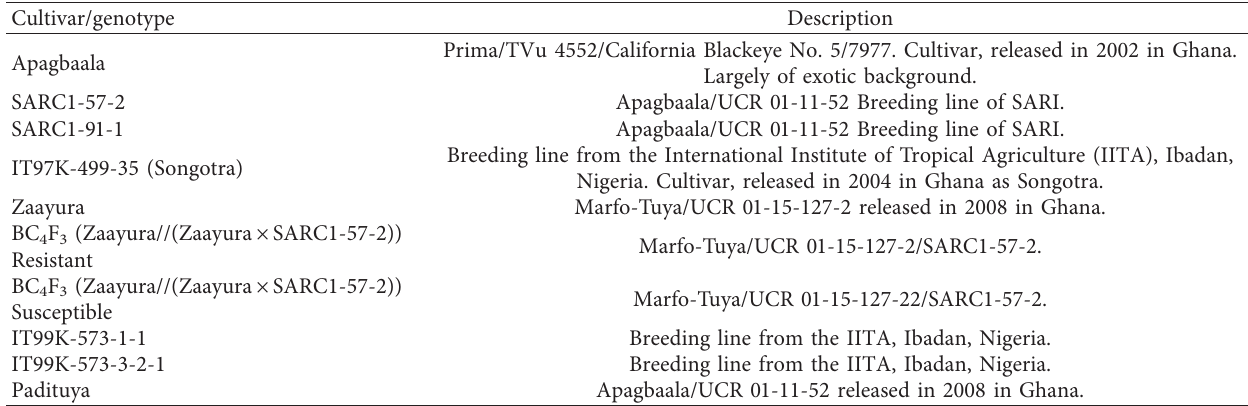
Figure 1: Spatial distribution of the study sites across six regions in Ghana. Table 1: Description of the cowpea genotypes by the parentage or